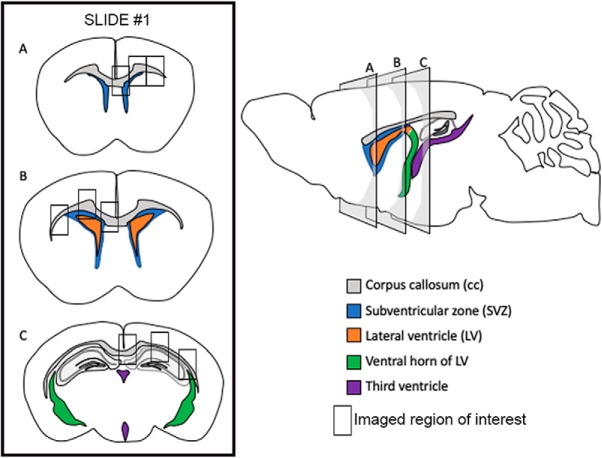

Illustration of sample collection and sectioning. Representative slide with three coronal sections (left, sections A–C) that correspond to three regions along the rostral-caudal axis depicted on the sagittal diagram of the mouse brain (right, regions A–C). A color-coded key indicates which structures on the coronal and sagittal sections are corresponding. The slide on the left also shows three small boxes on each section that correspond to regions imaged and used for analysis. Right and left sides were counterbalanced as shown.